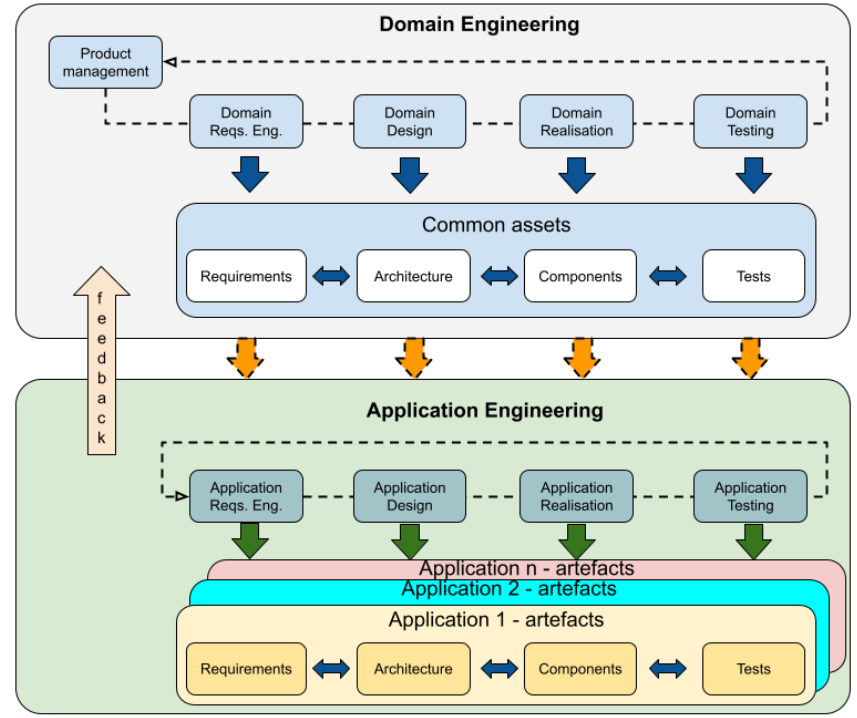
Figure 1. SPL framework, stages and their